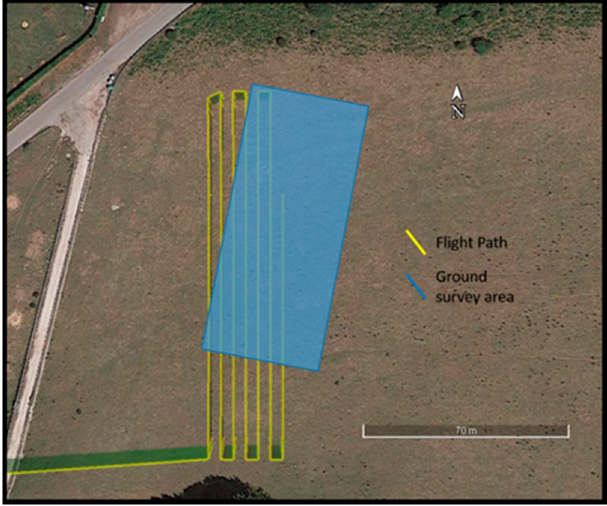
Figure 2. Planning of ground and aerial surveys.